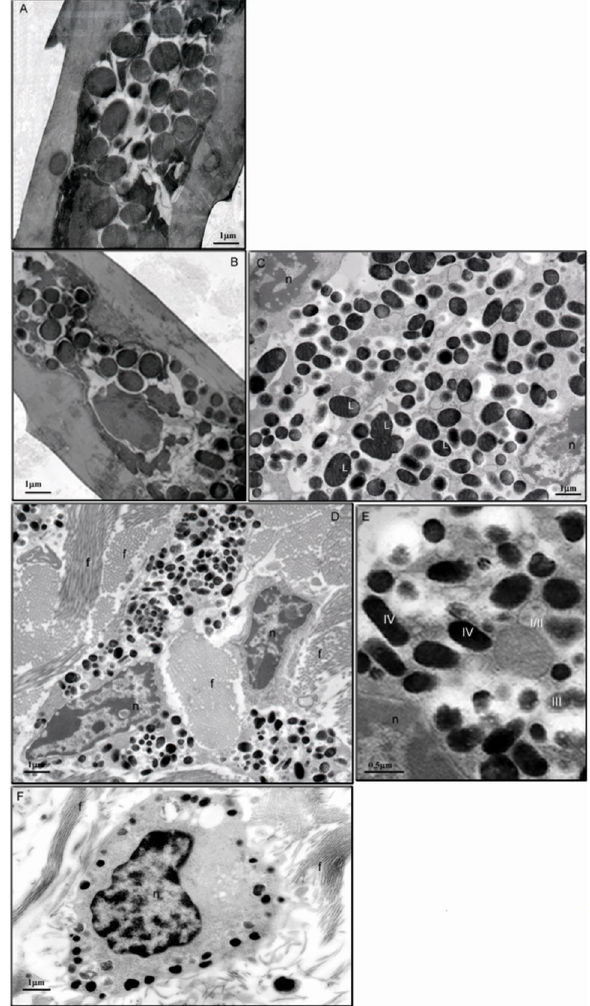
Figure 2. TEM pictures of melanocytes in mouse hair and skin. (A-B) Melanocytes in adult hair shaft; (A) wild-type HGF/SF transgenic mouse; (C) hair bulb. (D-E) adult skin.